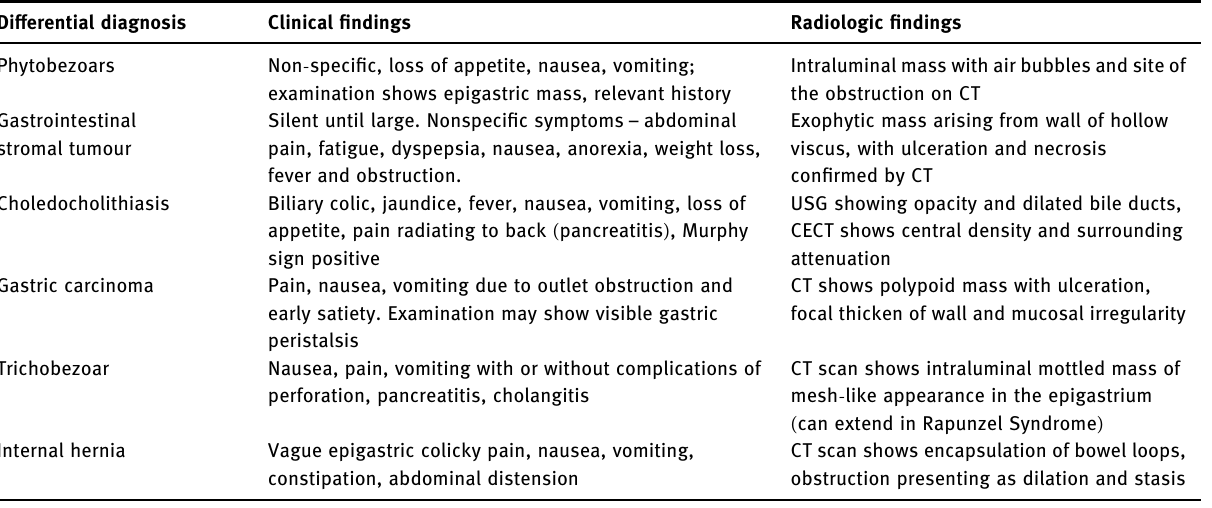
Table 2: Clinical and radiological di ff erential diagnoses Di ff erential